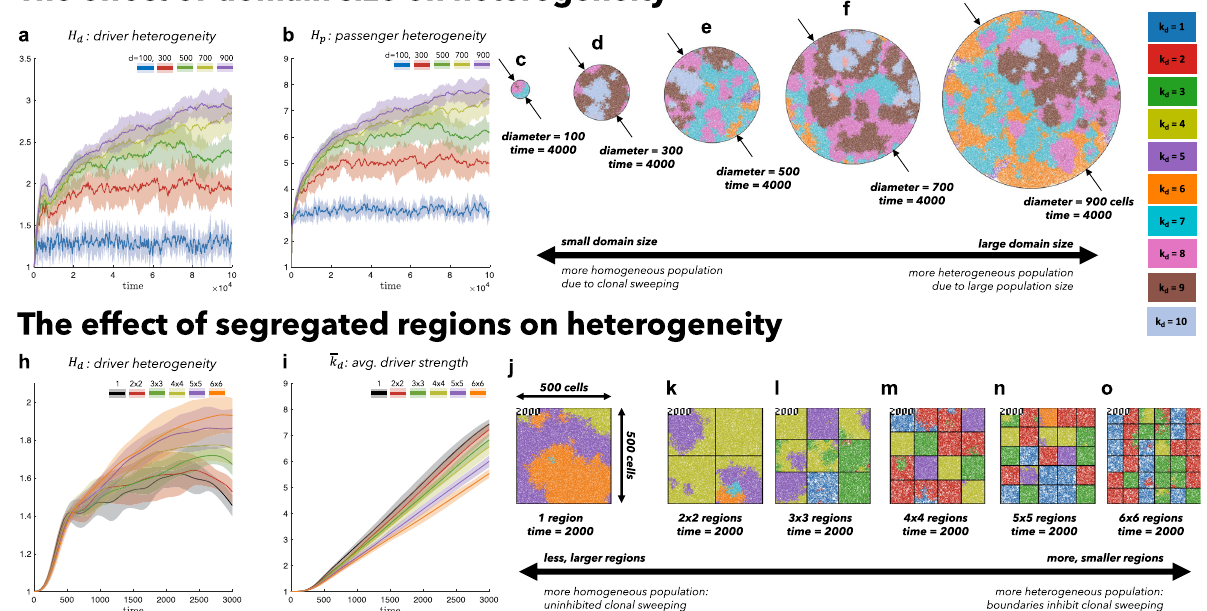
Fig. 1 The effect of spatial constraints on heterogeneity. Cells divide and die on a regular square lattice. A cell selected for birth can divide only into an empty grid location and may accrue passenger or driver mutations. Top: simulations on varied sizes of domains, ranging from 100 cells in diameter to 900 cells, seeded with 100 cells ( k d = 1, k p = 0) at time zero ( T p = 5 ⋅ 10 6 , T d = 700, s d = 0.1, s p = 0.01). a , b An increase in domain size results in increased driver and passenger heterogeneity, with standard deviation shown (shaded colors) for ten stochastic simulations. c – g Representative snapshots after 4000 cell generations. Bottom: Identical domain size (seeded with one-third of the domain fi lled; k d = 1, k p = 0) segregated into varied number of non-interacting regions ( T p = 10 6 , T d = 700, s d = 0.1, s p = 0.01, μ = 10 − 8 ). h driver heterogeneity increases with number of segregated regions. i Boundaries limit new clones from expanding beyond a single region, decreasing the average number of drivers in the population. j – o Representative snapshots after 2000 cell generations. See attached videos V1 and V2. Solid lines indicate mean value, bands indicate± 1 standard deviation for N = 10 simulations in a , b , h , i